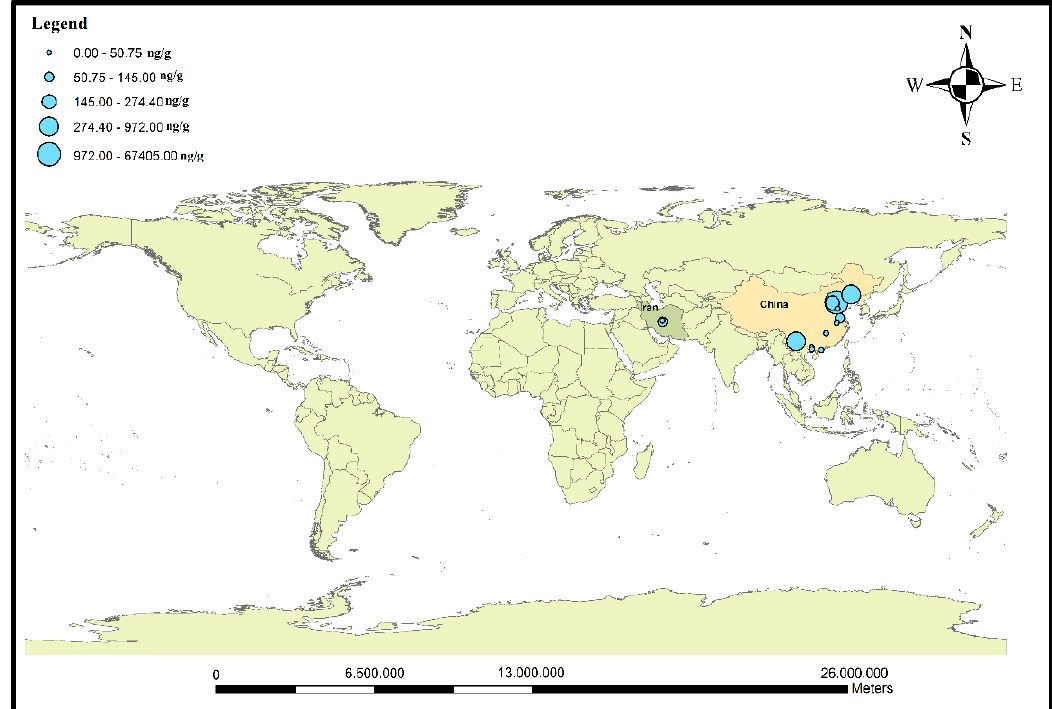
Figure 6. Antibiotic studies in biota in aquatic environments around the world. Table 5. Antibiotics reported in biota around the world. Region (Country) Geographical Coordinates Antibiotics in Biota (ng/g)